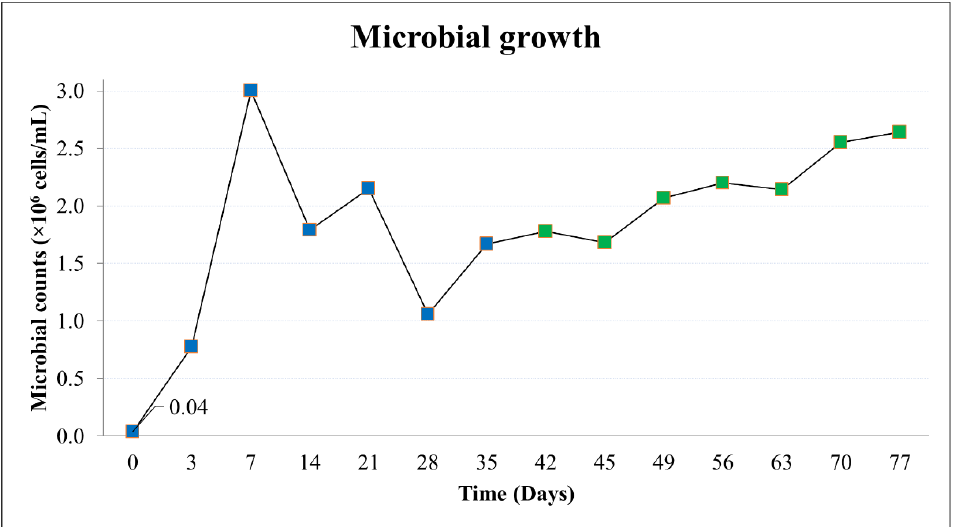
Figure 4. Microbial growth throughout the whole oil bioremediation experiment. Blue dots represent the microbial counts for the first phase of the experiment (OIL treatment), where only oil was added (0–35 days). Green dots represent the second phase of the experiment (OIL + D treatment), where oil and dispersant were added (42–77 days). Microbial counts on Day 0 denote the population of microorganisms in natural deep seawater.